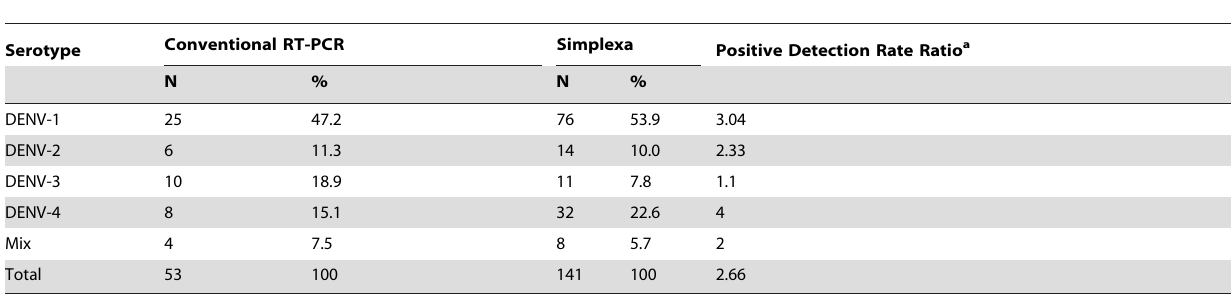
Table 3. DENV serotype positive detection rate ratio of Simplexa Dengue compared to conventional RT-PCR.